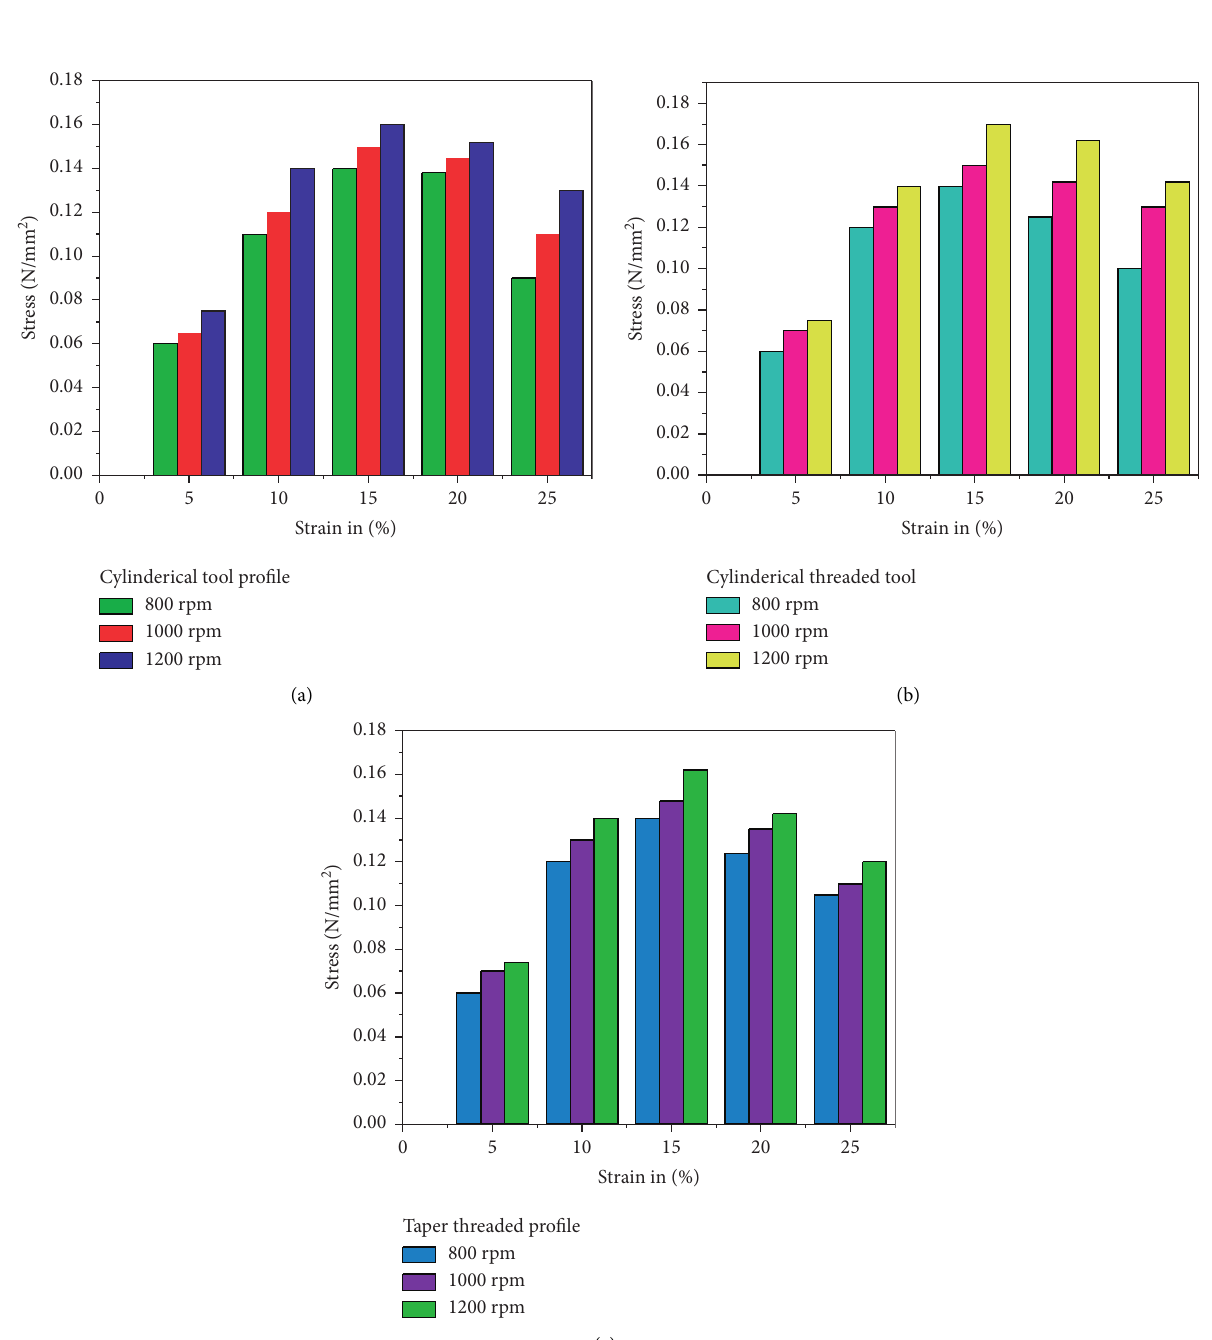
Figure 4: Tensile test: (a) cylindrical contour of the tool, (b) profile of a cylindrical threaded tool, and (c) profile of a tapered